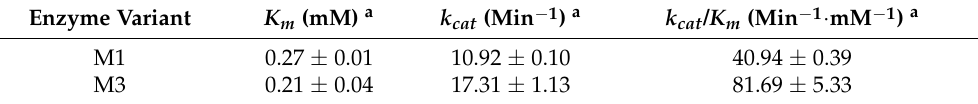
Table 2. The kinetic constants of M1 and M3 (cyp153a-ncp G307A/R14R/D629G ) towards